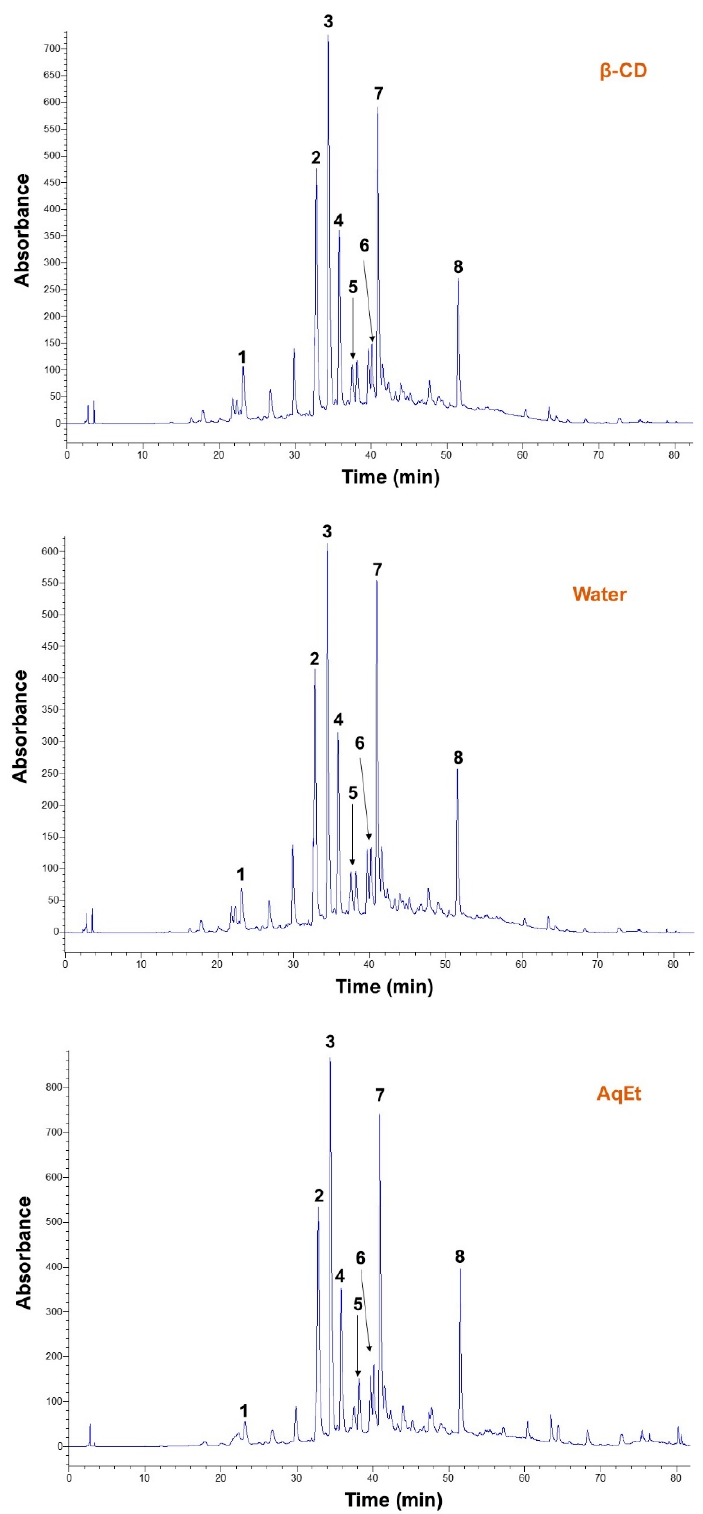
Figure 4. Chromatograms of M. piperita extracts were recorded at 320 nm. AqEt extract corresponds to 60% aqueous ethanol. For the β -CD-aided extraction, a β -CD concentration of 1.08 mM was used at 80 °C for 180 min. Peak assignment: 1, caffeic acid; 2, eriocitrin; 3, luteolin 7- O -rutinoside; 4, luteolin 7- O -glucuronide; 5, narirutin; 6, hesperidin; 7, rosmarinic acid; 8, luteolin derivative.